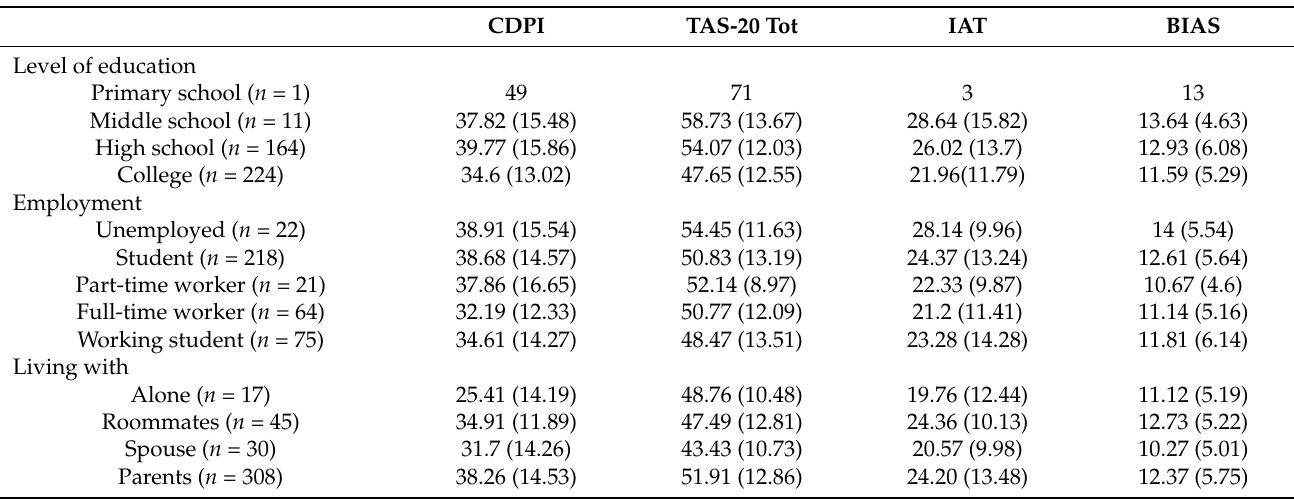
Table 1. Means and standard deviations of emerging adults’ scores on CDPI, TAS, IAT, and BIAS, based on demographic variables.